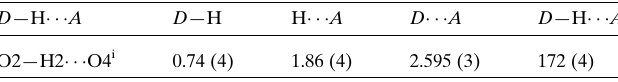
Table 1 Hydrogen-bond geometry (A˚ , (cid:3) ).